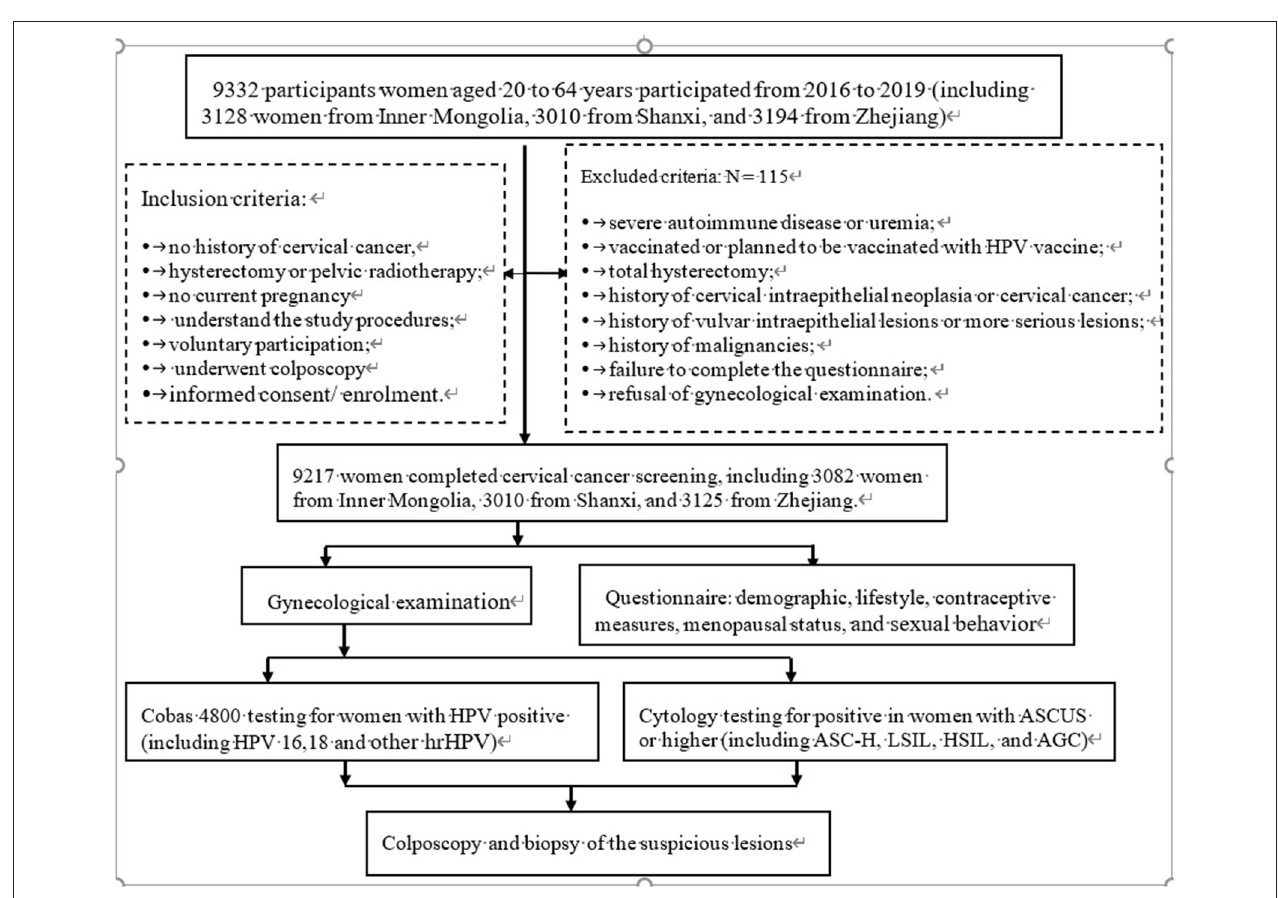
FIGURE 1 | The flow chart of the study procedures carried out on the sites. ASCUS, atypical squamous cells of undetermined significance; ASC-H, higher including low-grade squamous cell-cannot exclude high-grade squamous intraepithelial lesion; LSIL, low-grade intraepithelial lesion; HSIL, high-grade squamous intraepithelial lesion; AGC, atypical glandular cell; NILM, negative for intraepithelial lesion or